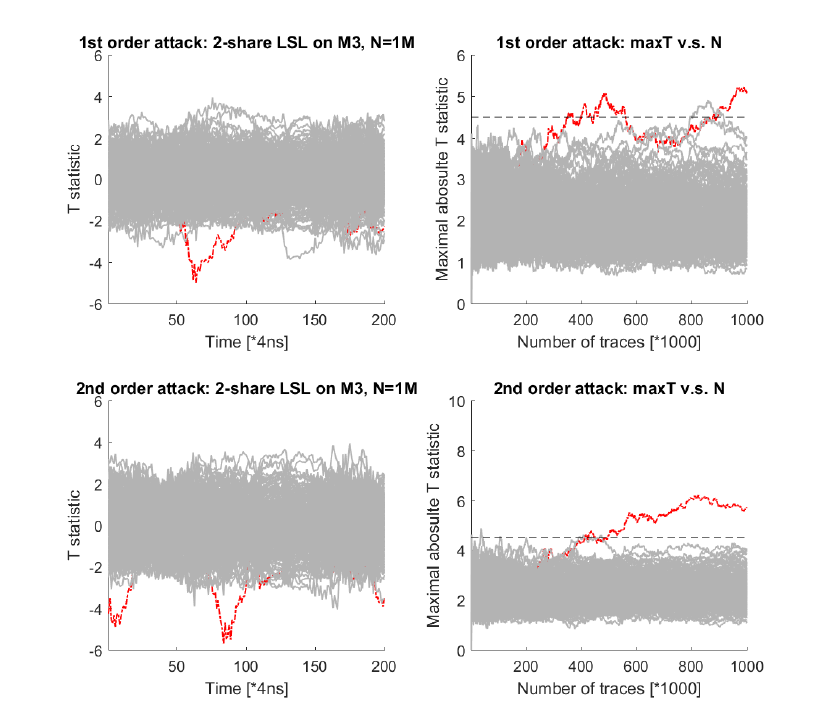
Figure 9: Attacking the 2-share version on